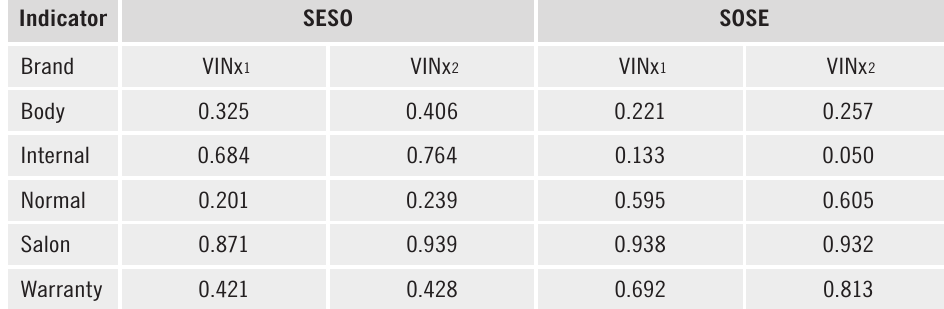
Table 5. Summary of SESO and SOSE indicators in 2018 in the examined organization